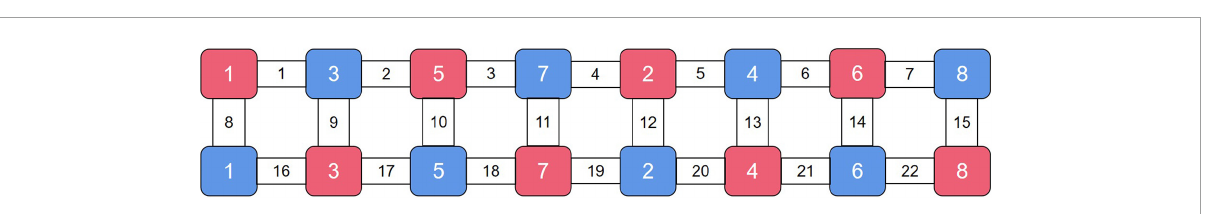
FIGURE1 The procedure of one trial under winter conditions.